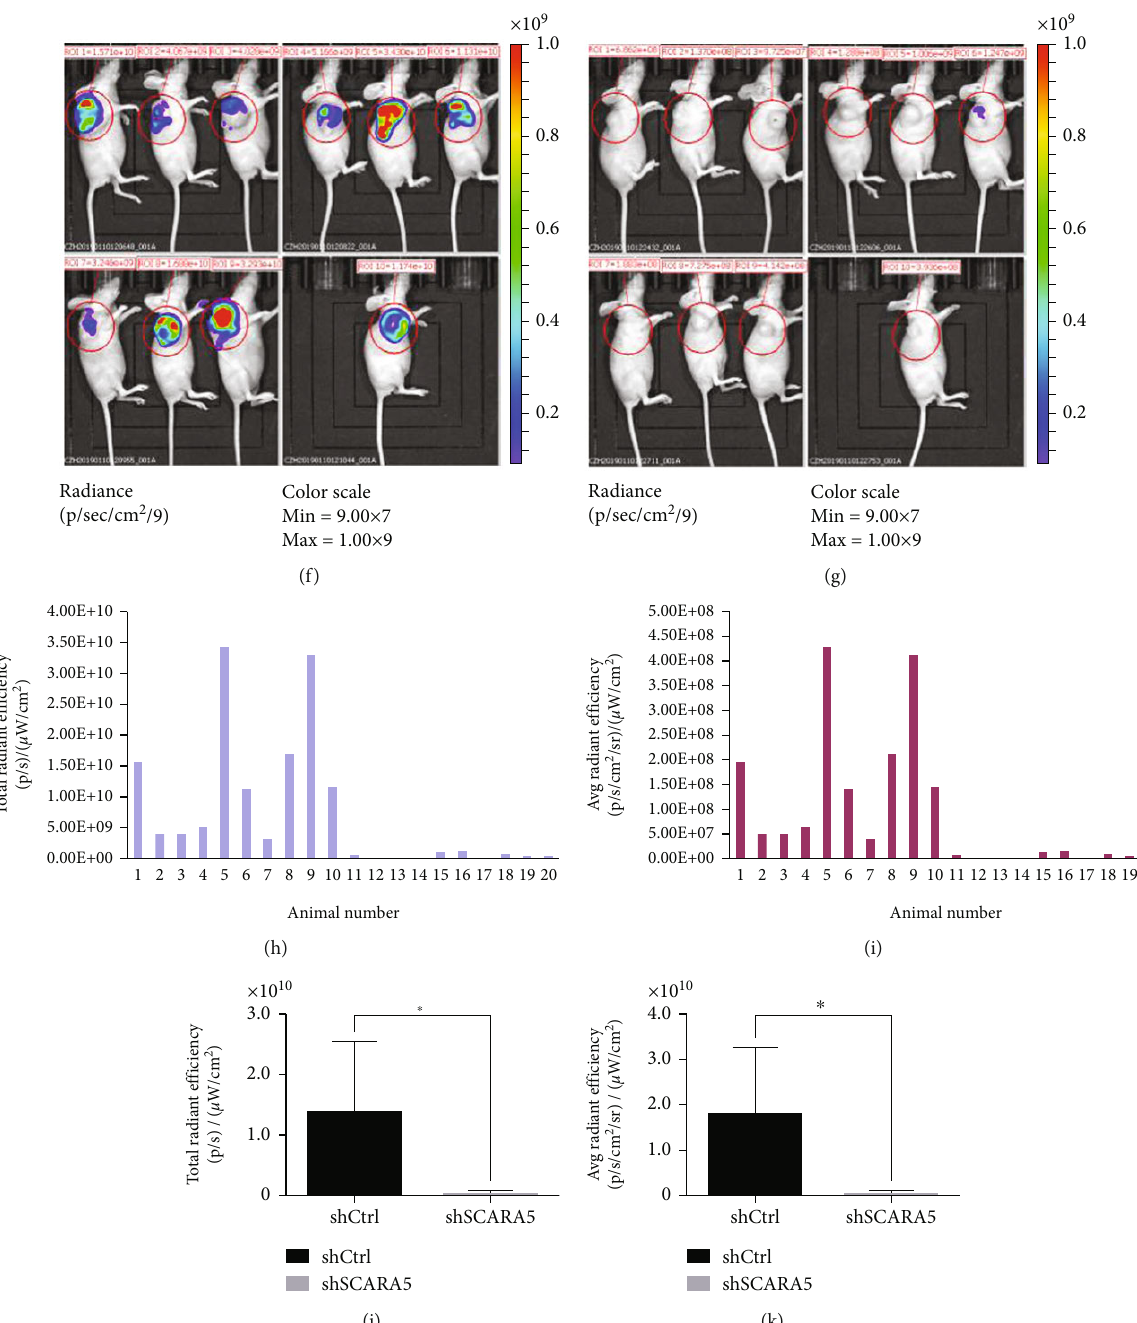
Figure 3: E ff ect of SCARA5 knockdown on subcutaneous tumorigenicity of ESCC cells in vivo . (a) Pictures of the Eca109 cells form the KD and the control groups were captured by Celigo imaging cytometer after sh- SCARA5 transfection and before injection. (b) Expression of SCARA5 at mRNA level in the Eca109 cells was detected using qRT-PCR after shRNA transfection. (c – e) Tumor volume and tumor weight were analyzed between the KD group and the control group to evaluate the e ff ect of SCARA5 knockdown on subcutaneous tumorigenicity of ESCC cells in vivo . (f – k) The vivo imaging assay was applied to evaluate the subcutaneous tumorigenicity of ESCC cells in the KD and the control groups. ∗ P < 0 : 05